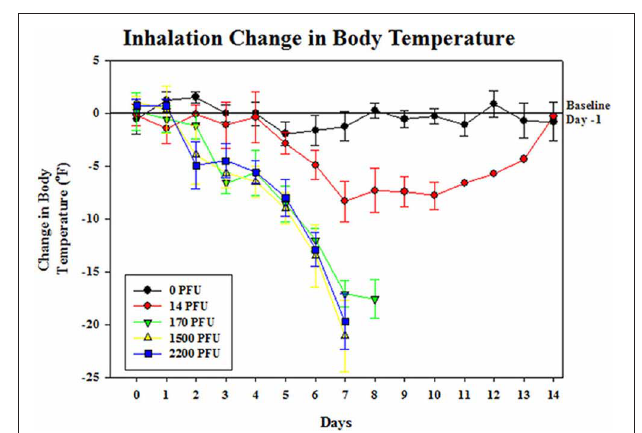
FIGURE 5 | Change in body temperature for groups of mice challenged with PR8 aerosol. Temperatures of mice in each group ( n = 8) were recorded individually on each day after challenge. The graph shows group mean change in temperature relative to the baseline temperature collected prior to challenge on Day 0 Error bars are ± standard deviation of the